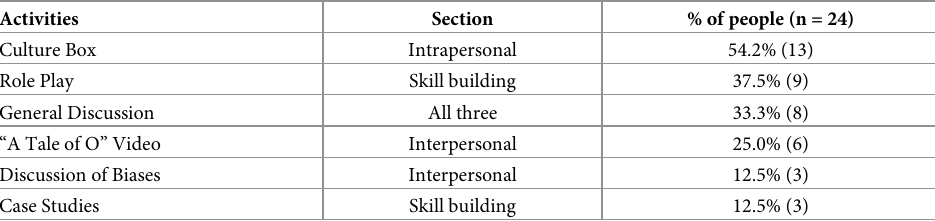
Table 1. Activities in CAM training recalled by